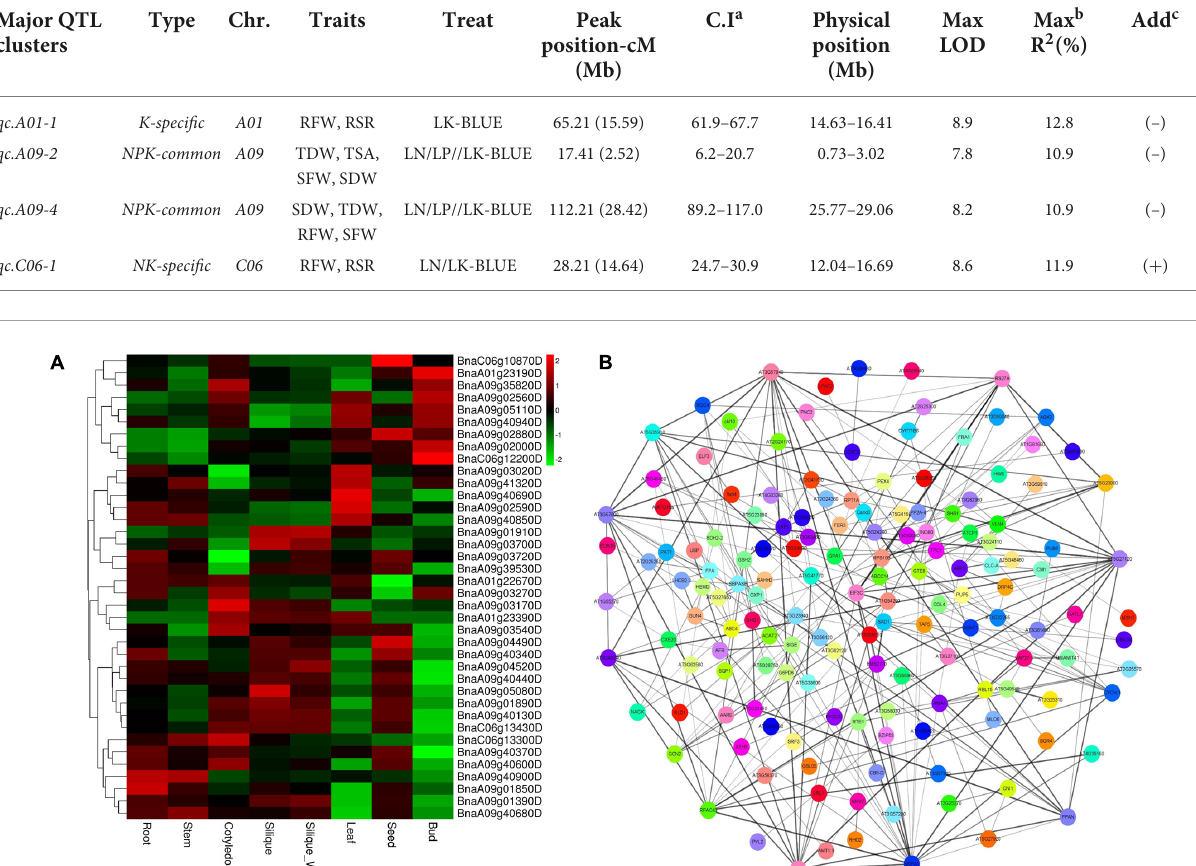
TABLE 3 Information of major quantitative trait loci (QTL) clusters with their physical position detected under NPK-stress in the recombinant inbred line (RIL) population. Major QTL clusters